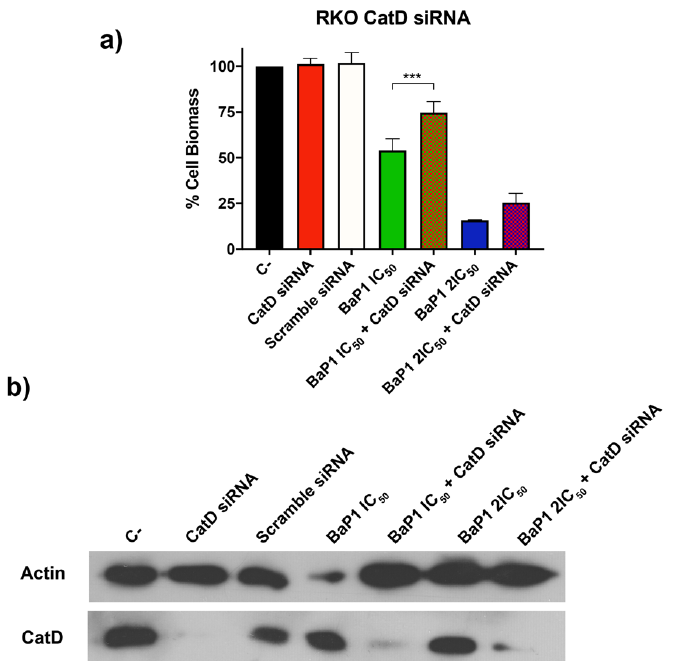
Figure 8. Effect of BaP1 on cell growth of Cathepsin (CatD) selected RKO cells. ( a ) Quantification of RKO cell growth assessed by SRB assay of unexposed and exposed CatD transfected cells to 48 h of BaP1 IC 50 and 2 × IC 50 . As controls, RKO cells were not transfected (C-, BaP1 IC 50 , and 2 × IC 50 ) and transfected with scrambled siRNA. Values are means with SD (n ≥ 3). Statistical analysis was performed by one-way ANOVA. *** p < 0.001. ( b ) Confirmation of CatD depletion by Western blot analysis of CatD expression for all the conditions. Actin was used as expression control.